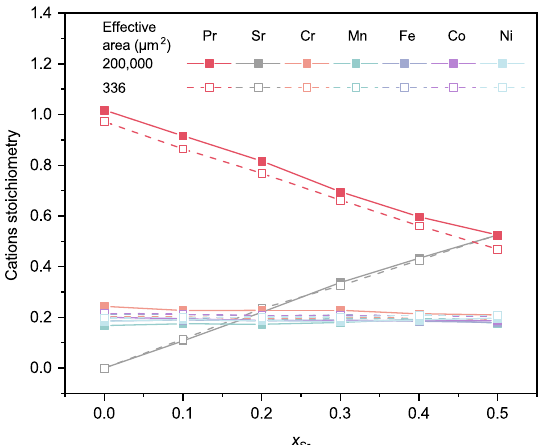
Figure 4. Cation stoichiometry of Pr 1– x Sr x (Cr,Mn,Fe,Co,Ni)O 3– δ ( x = 0–0.5) calculated from results of EDXS (Tables A4 and A5) under the assumption that the sum of A-site cations and B-site cations is two. The solid lines present data obtained on an effective area of 200,000 µm 2 by a lithium-drifted silicon detector while the dashed lines are data on an effective area of 336µm 2 by silicon drift detectors. The cross-sections of samples were vibratory-polished and sputtered with a carbon layer before